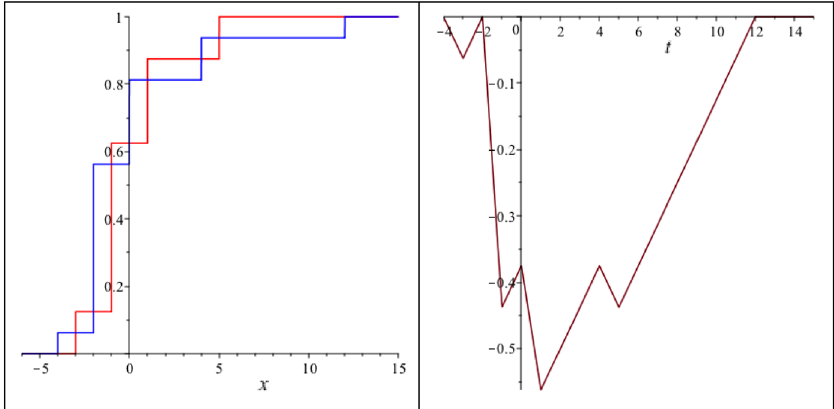
Fig. 3 S 3 s -order stochastic dominant over S 4 . On the left: cumulative distributions of S 3 (red) and S 4 x (blue); on the right: R ½ S 3 ð z Þ(cid:3) S 4 ð z Þ(cid:5) d x (cid:3) 4 Table 5 Illustration of valuations of St. Petersburg games with linearity in probabilities and power function of